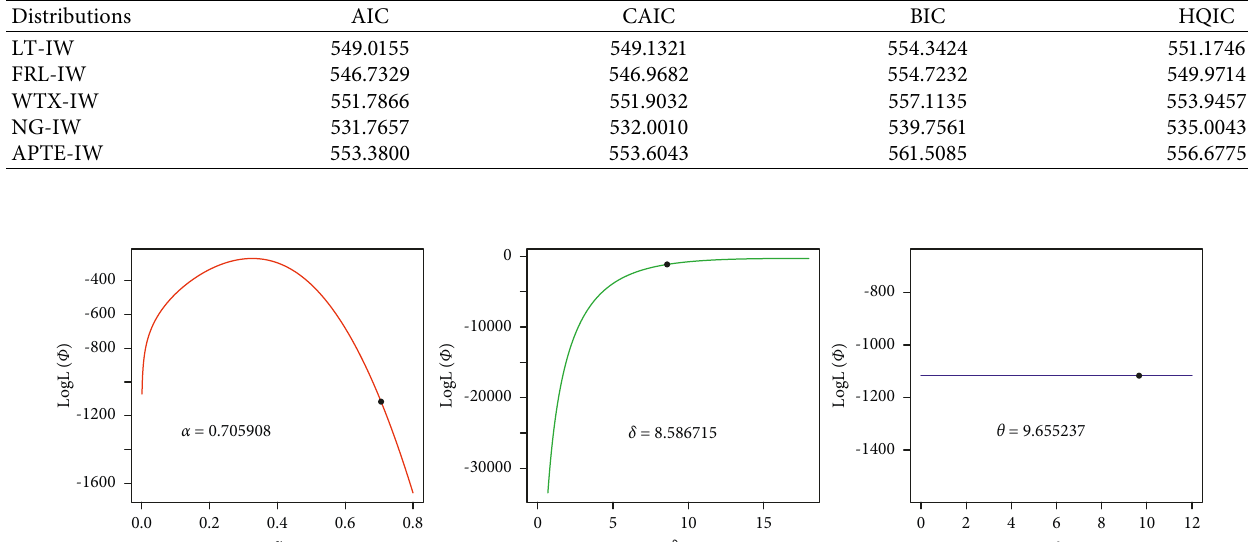
Table 2: The values of the analytical measures of the fitted models using the COVID-19 data set.